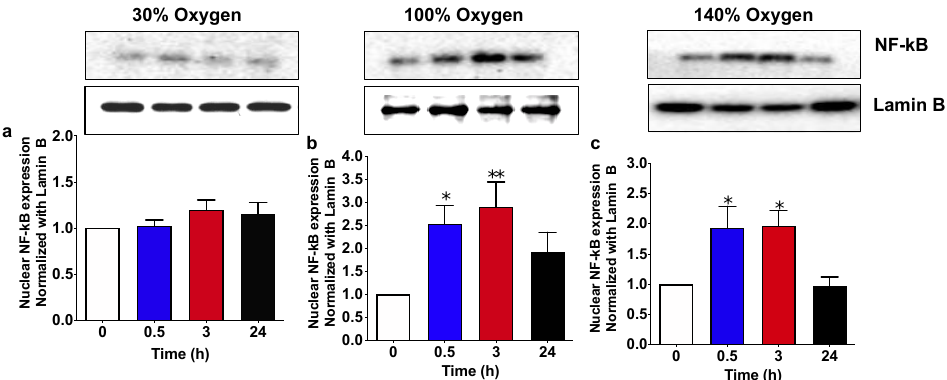
Figure 3. NF- κ B (p65 subunit) nuclear translocation following 1 h hyperoxia. ( a ) Mild hyperoxia (30% O 2 ); ( b ) high hyperoxia (100% O 2 ); ( c ) very high hyperoxia (140% O 2 ) before and after the recovery to normoxic conditions. Above histograms, the picture shows a representative western blot analysis. Results are expressed as fold change (mean ± SEM) in comparison to baseline (0), which was set at 1. * p < 0.05, ** p < 0,01; for one-way ANOVA followed by Dunnett’s post hoc test.